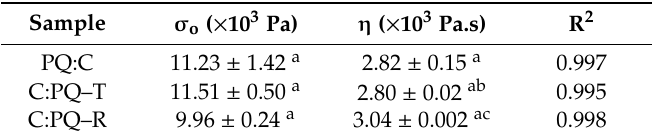
Table 3. Rheological properties of filmogenic